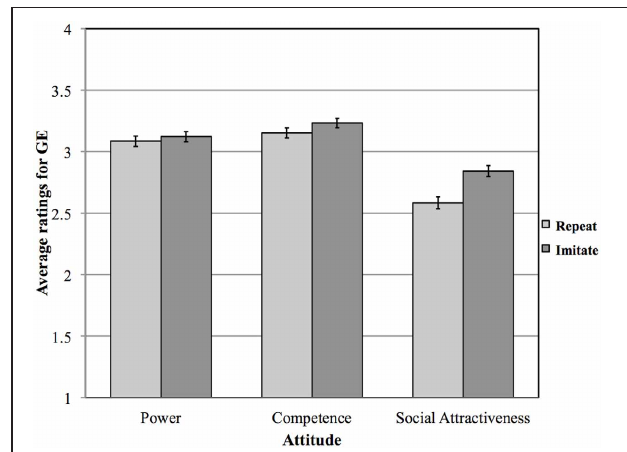
FIGURE 1 | Average rating scores for Task: Repeat and Imitate, and Attitude: Power, Competence and Social Attractiveness (error bars represent one standard error of the mean) for both GE